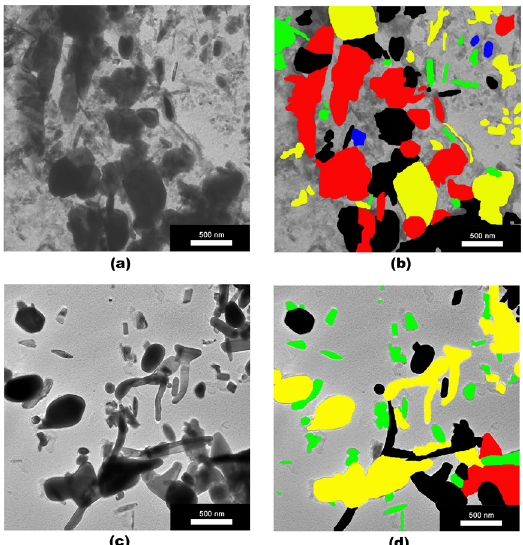
Figure 9: TEM carbon replicas images of phases identified in the samples aged at 600°C and 1000 h: (a) and (b) ferritic-pearlitic, C (c) and (d) ferritic-bainitic. Carbides are identified by colors: M 2 C (black), M C (yellow), M C (blue), M C (green), M 23 6 7 3 3 6